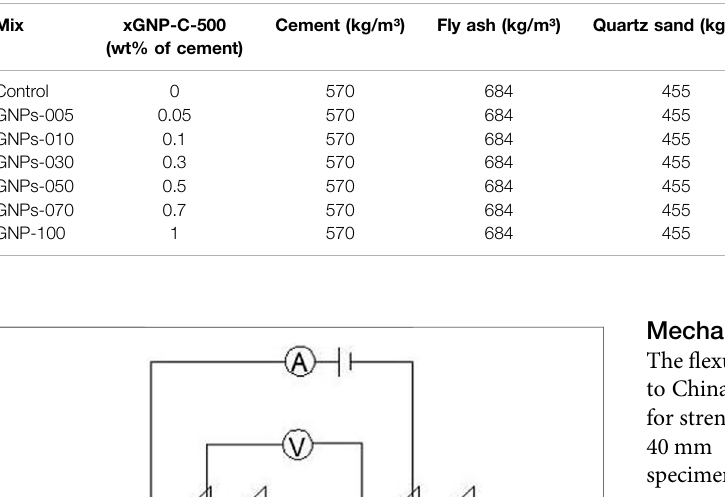
TABLE 1 | Mix proportion of mortar fl uidity test.